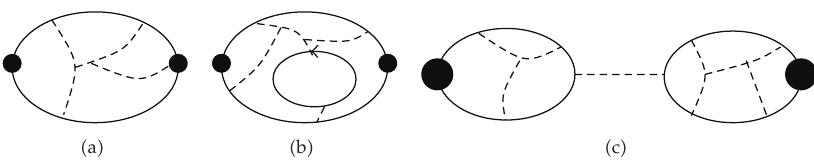
Figure 1: Diagrams for a meson propagator, with two insertions of the meson operator (cid:5) n (cid:7) 2 (cid:6) shown as thick points on the boundaries. The dashed lines are gluons that fill the diagram in the large N c limit and the thick lines are quarks. (cid:5) a (cid:6) Planar diagram with no internal quark loops (cid:5) h (cid:7) 0, w (cid:7) 0 (cid:6) , the scaling is ∼ 1. (cid:5) b (cid:6) Planar diagram with an internal quark loop h (cid:7) 0, w (cid:7) 1, the scaling is ∼ N diagram with no internal quark loops h (cid:7) 0, w (cid:7) 0, b (cid:7) 2, the scaling is ∼ 1 /N c